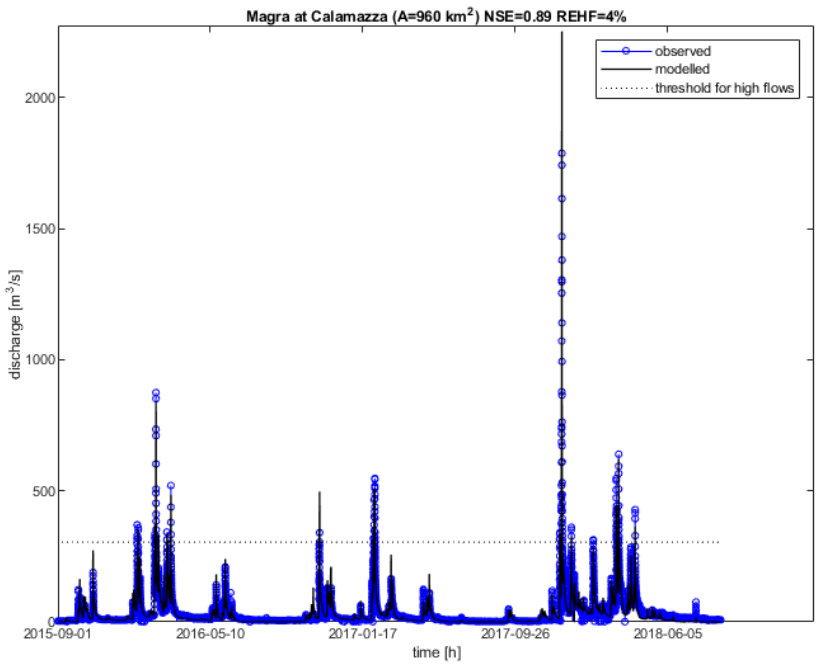
Figure 16. Comparison between observed and modelled hydrographs for a calibrated section.